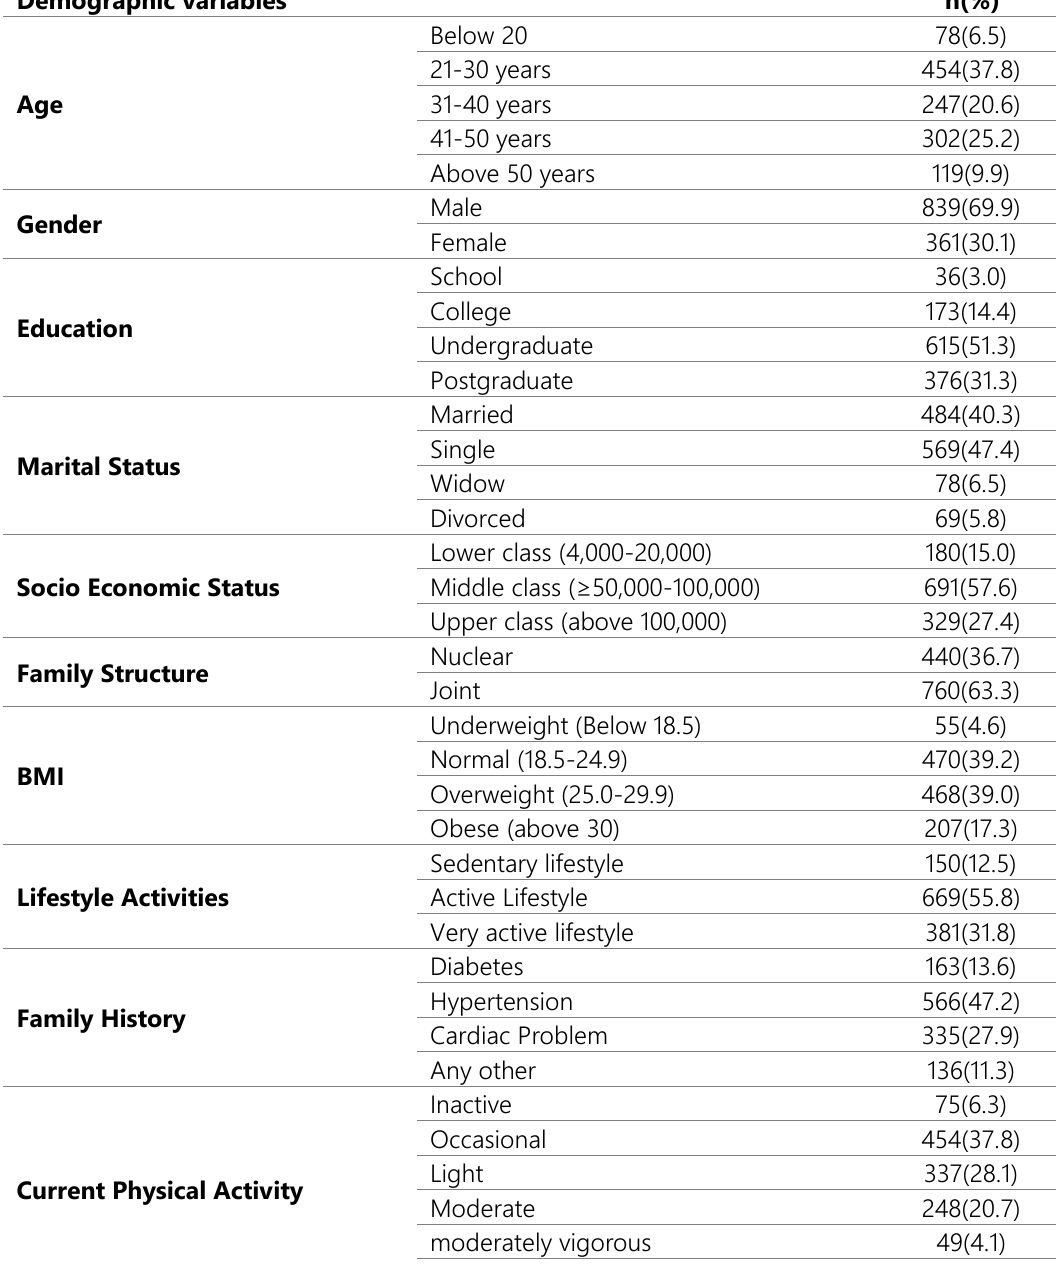
Table 1: Demographic characteristics of studied participants